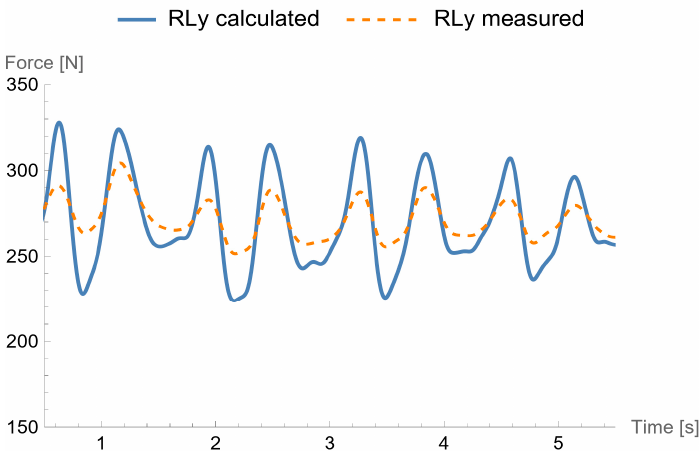
Figure 8. The vertical component, RL y , of the GRF for the left foot in the case of the exercises with upper limbs swinging. The RL y measured with the dynamometric plate is drawn using the dashed line, and the RL y calculated is drawn using the solid line. The error δ = 0.0841.